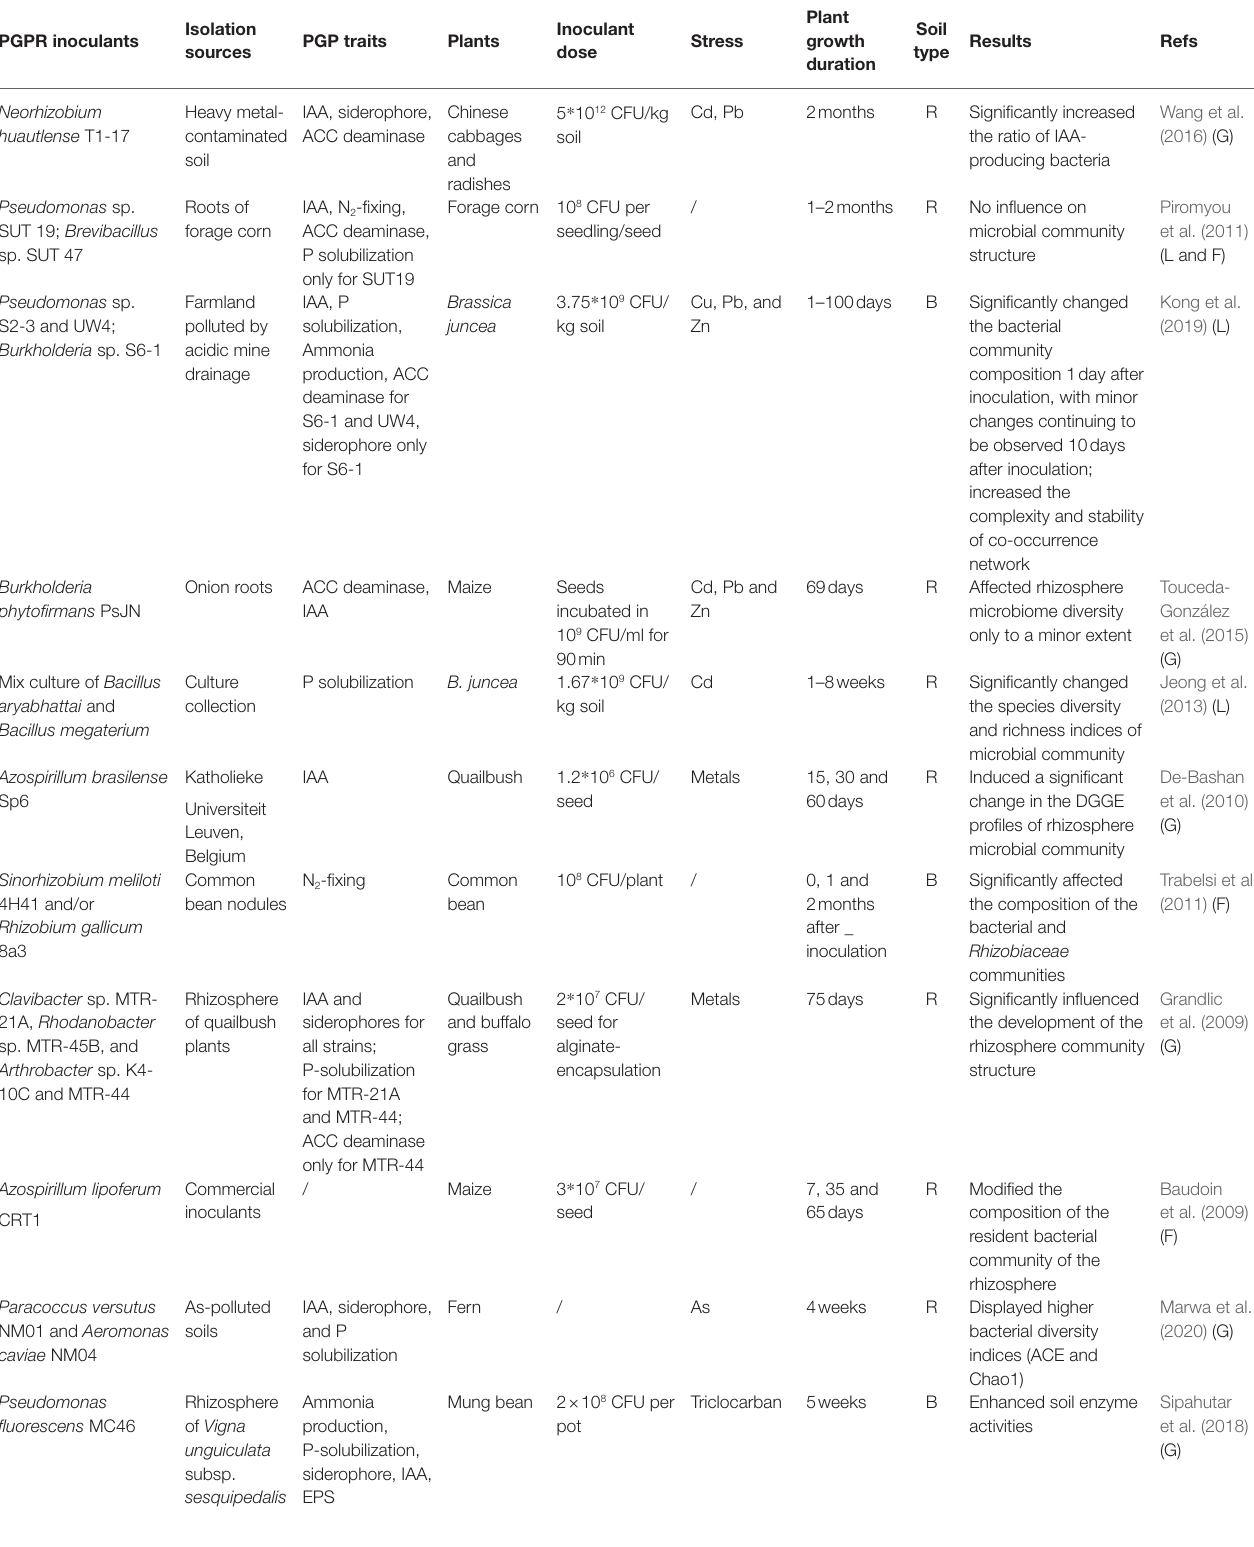
TABLE 1 | The effects of PGPR inoculants on soil microbial community composition and activity.